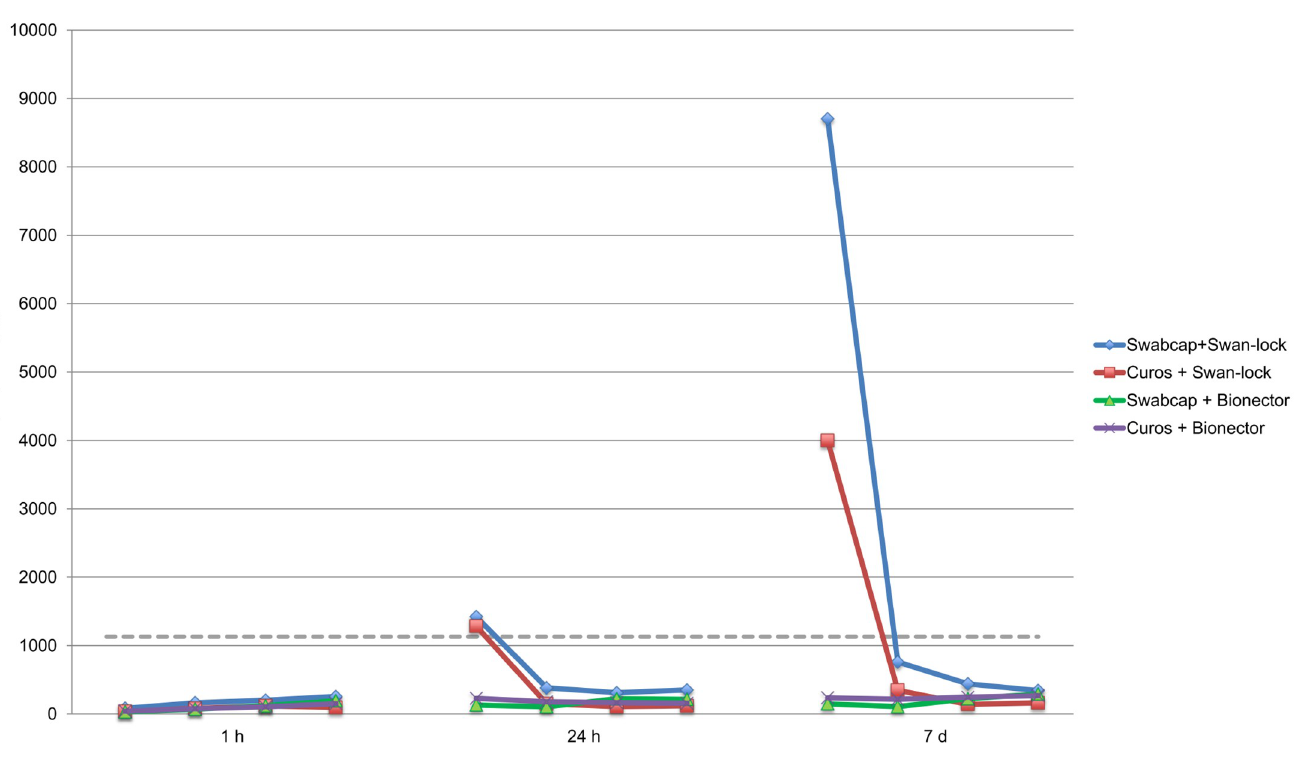
Fig 4. IPA leakage. Median amounts of isopropanol (IPA) derived from measurements of six replicates of each cap circuit. Circuits with the same cap and hub combination are represented by the same color. The four dots per line illustrate the median value of each of the four consecutive injections administered to the six circuits. The black dotted line represents the critical concentration of 1130 μ